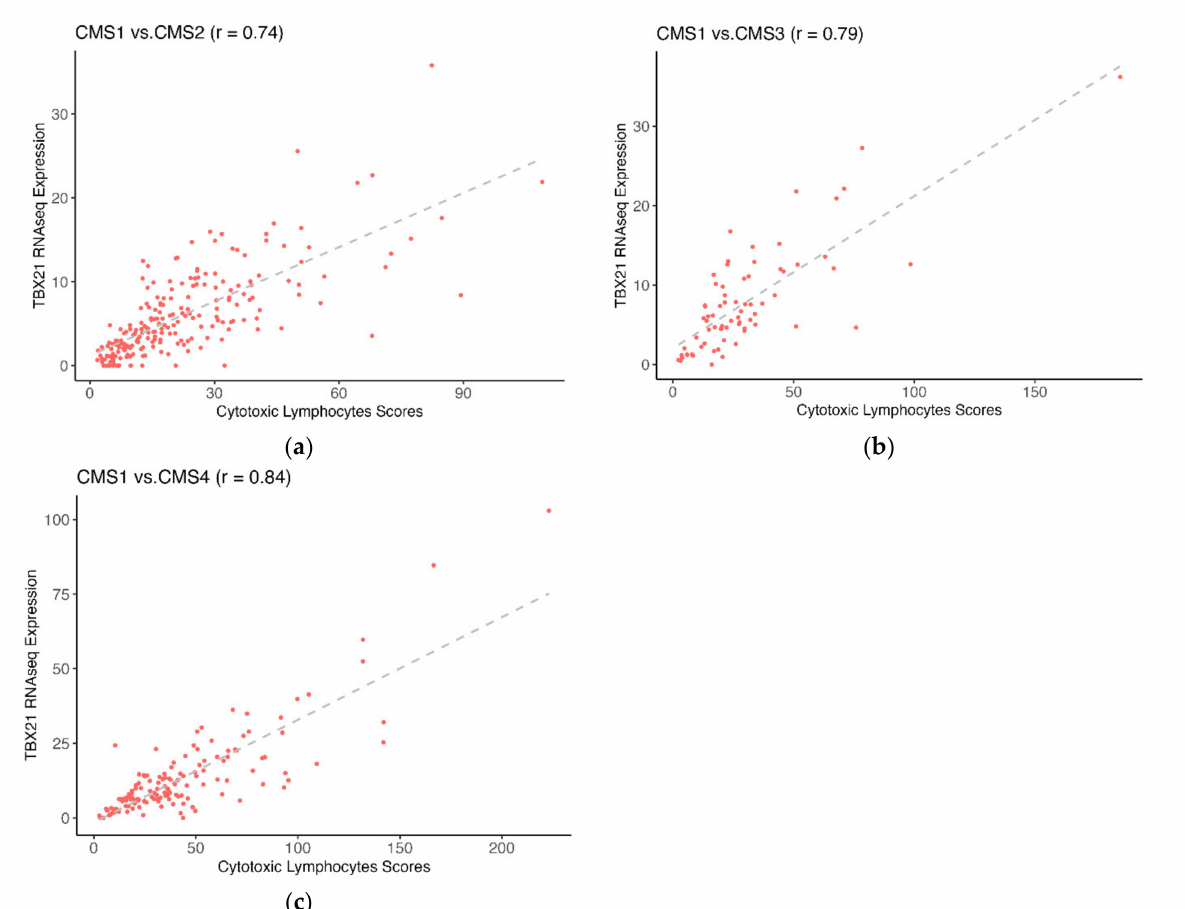
Figure 4. TBX21 was highly correlated with CTL. The x-axis is the CTL score, the y-axis is the normalized TBX21 mRNAseq expression. ( a ) Normalized TBX21 expression was highly correlated with CTL in CMS2. ( b ) Normalized TBX21 expression was highly correlated with CTL in CMS3. ( c ) Normalized TBX21 expression was highly correlated with CTL in